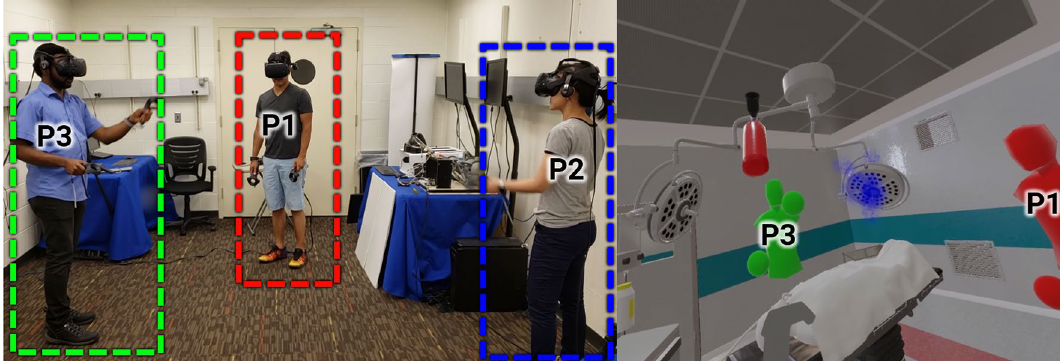
Figure 1. A group of users working through a trial of the multiplayer simulator at the network control conditions. Participants are outlined in their respective avatar color in the VR environment. P3 (green, left) is tossing a virtual fire extinguisher to P2 (blue, right) while P1 is viewing the interaction (middle, red). The VR rendering is from P2’s perspective, so P2 is not visible in the image on the